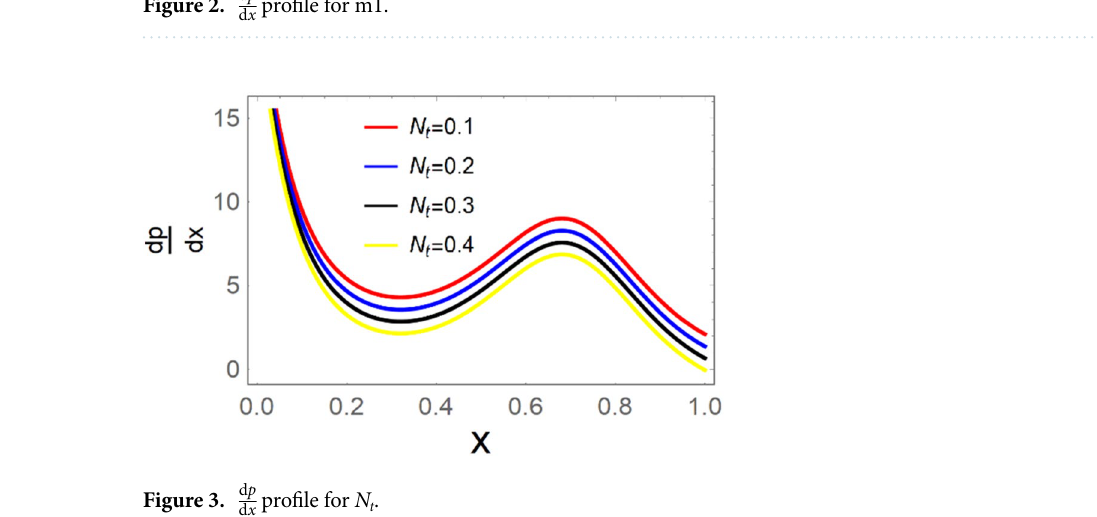
d p d x profile for m1.